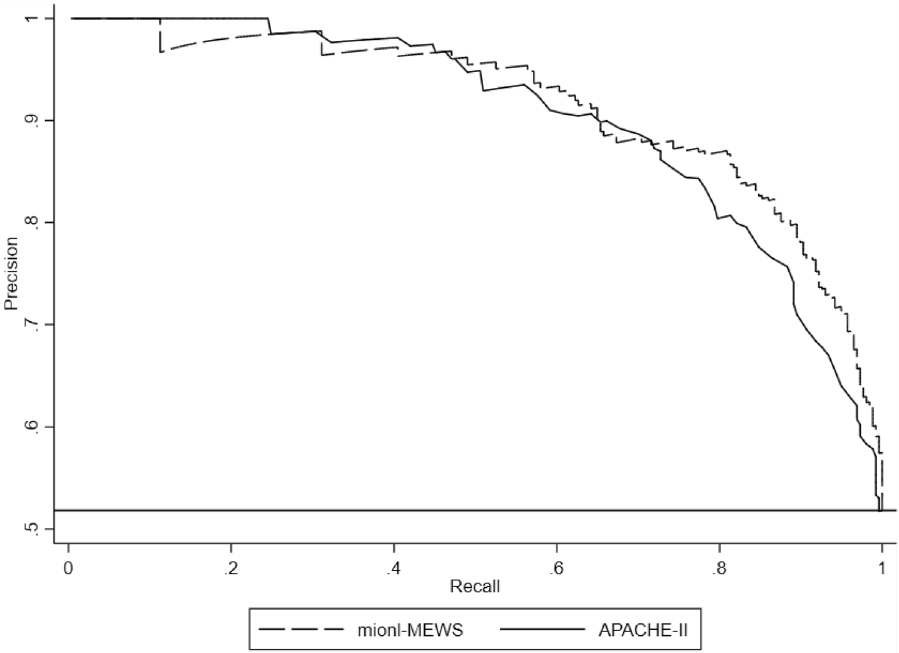
Figure 7. Comparison of precision-recall area under the curves (PR-AUCs) between the mionl-MEWS and APACHE-II in the validation cohort.